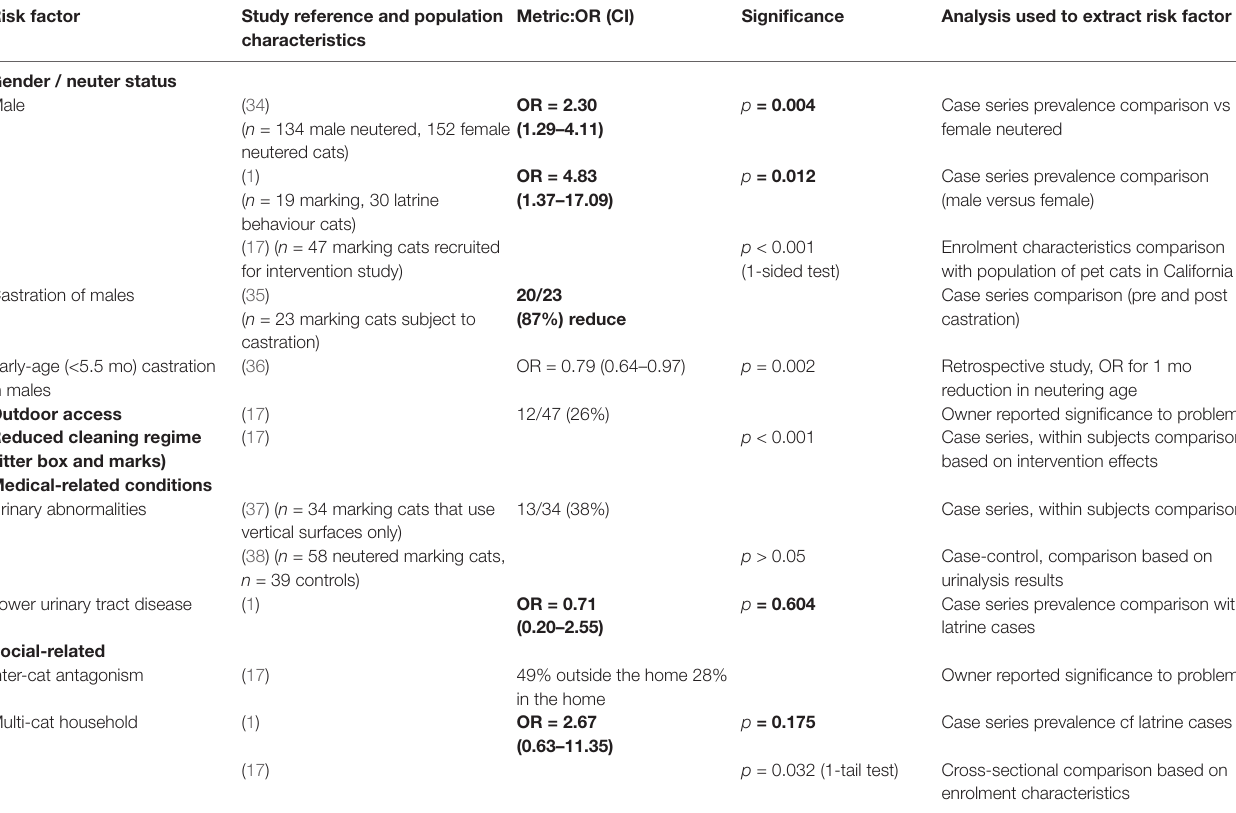
TaBle 1 | Risk factors for a urinary marking problem in the home and associated data from a review of the